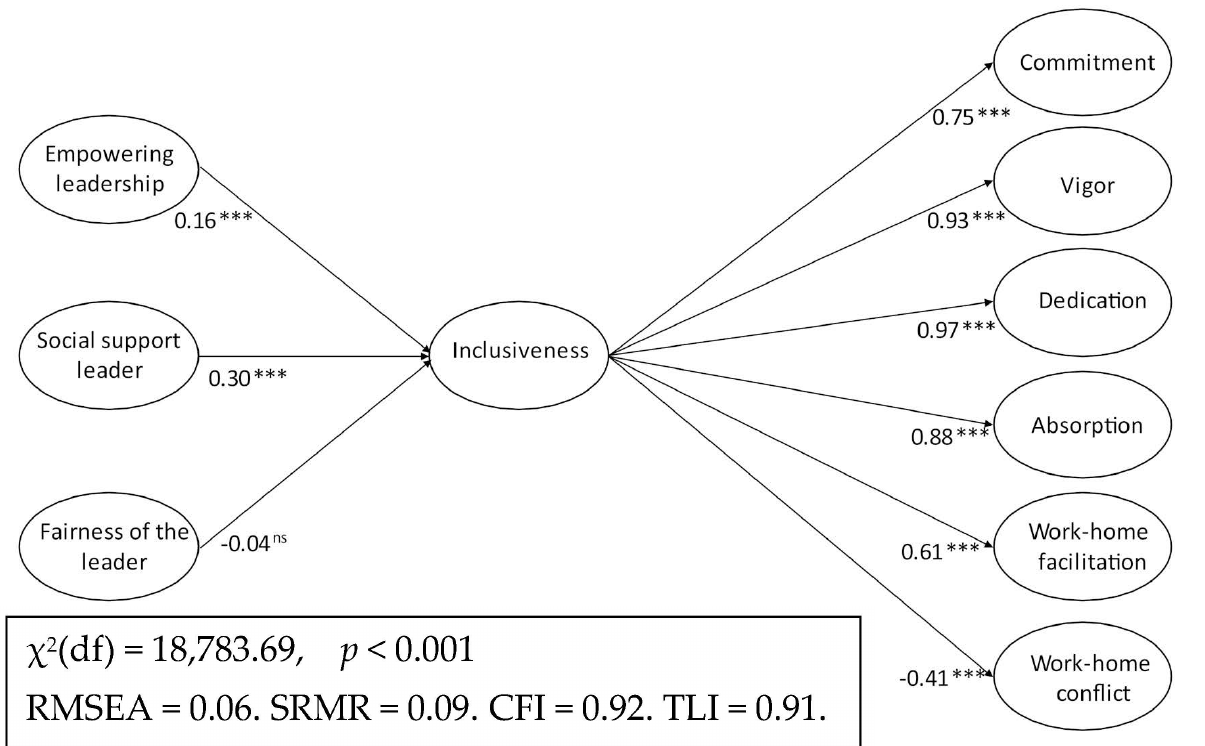
Figure 1. Structural model with standardized parameter estimates. Note: ***: p < 0.001; ns = not